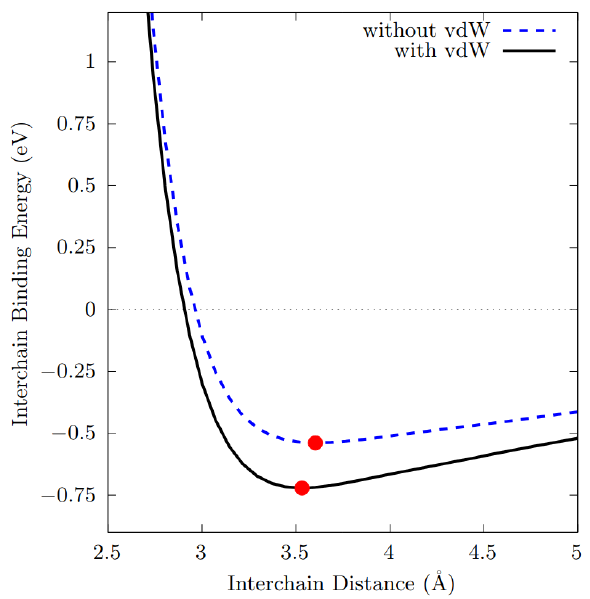
Figure 11. Interchain binding energy as a function of the interchain distance, with and without the inclusion of the Grimme’s DFT-D2 vdW correction. In both case, the chains possess the same fixed geometry. Red dots correspond to the equilibrium interchain separation of minimum energy for the two cases. Energy rescaled with respect to the relative isolated chains (with and without